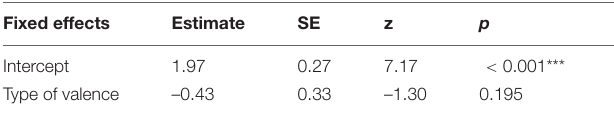
TABLE 5 | Model parameters for the best-fitting model for ACC in Experiment